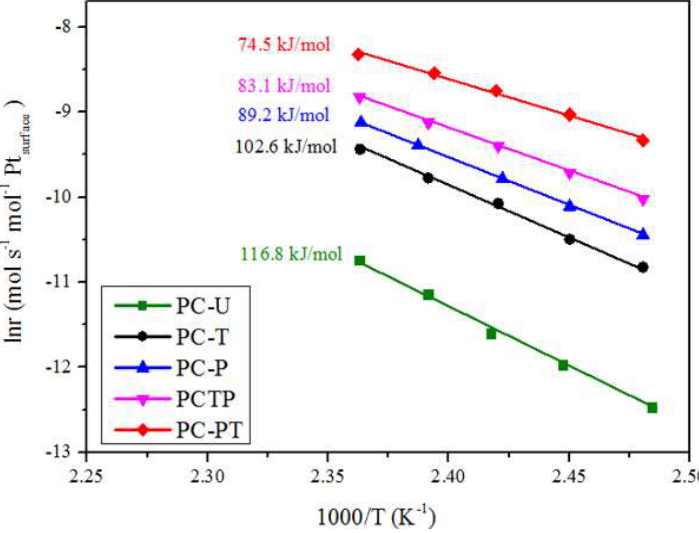
Figure 2. Arrhenius plots for the oxidation of toluene over different Pt/CeO 2 catalysts.